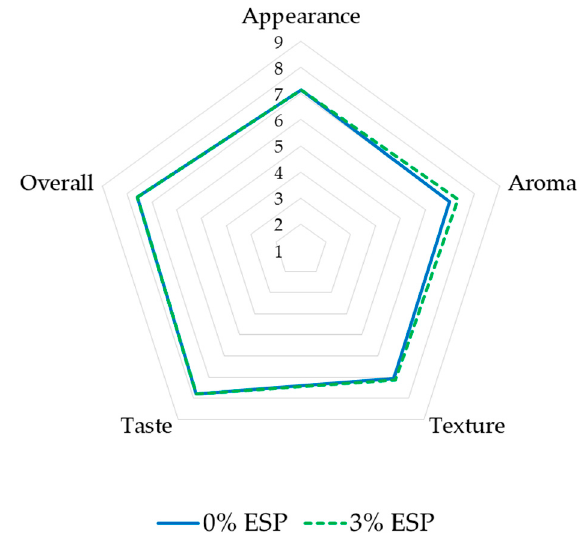
Figure 5. Hedonic evaluation of fresh gingerbread samples; ESP: eggshell